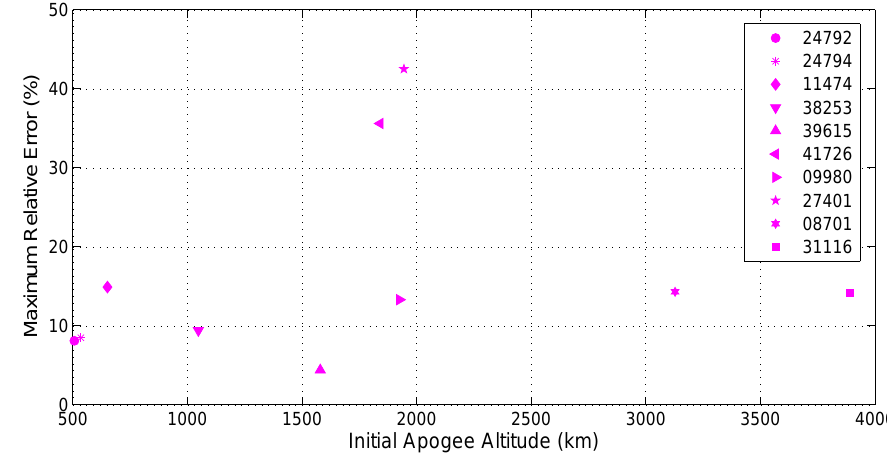
Figure 3. Maximum relative error of ten re-entered objects with low-eccentricity orbits in 2017